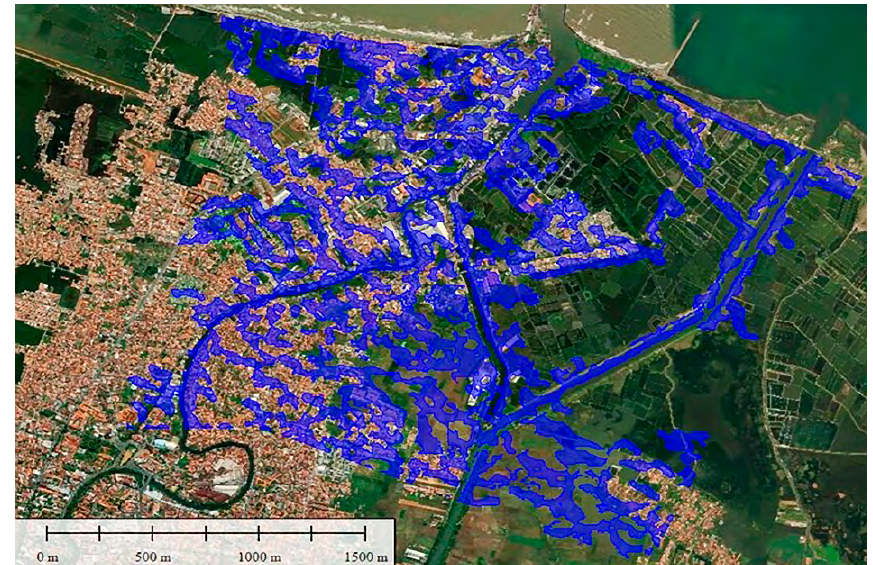
Figure 14. The Result of hydraulic flood two dimentional modelling in Pekalongan